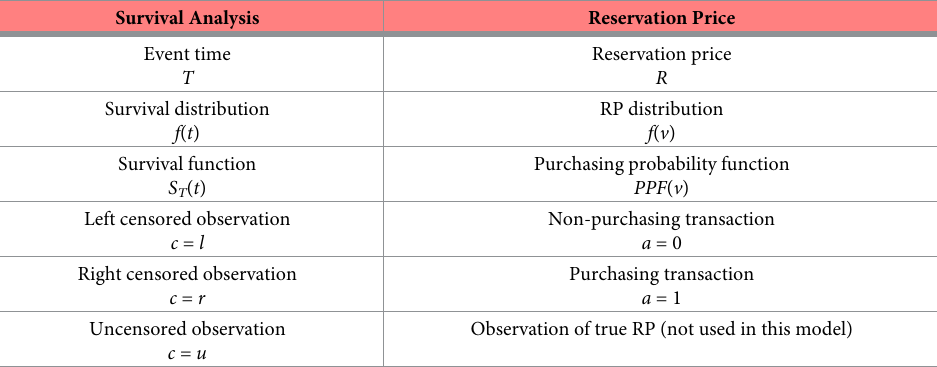
Table 2. Matching terminology and symbols.